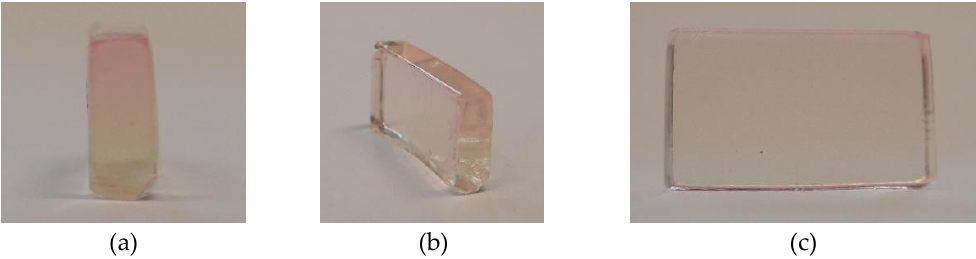
Figure 7. Photographs of gelatin nanoparticle gradient material with a gradient of RITC-SiNPs from three different views: frontal view in ( a ), oblique view in ( b ) and side view in ( c ). The dimensions of the material are 1.2 cm × 0.7 cm × 0.3 cm.